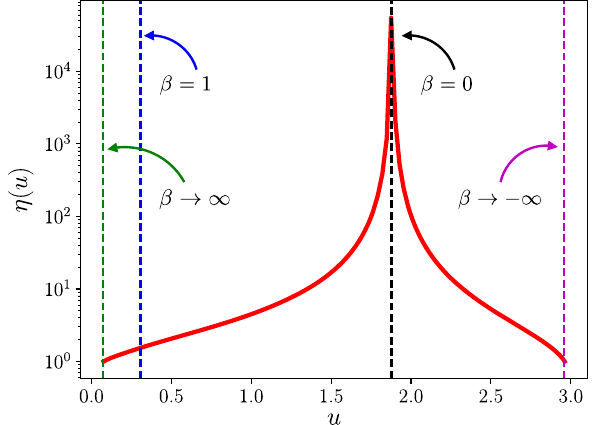
FIG. 9. Classical-to-quantum memory ratio for biased sampling of Ising spin configurations: η ð u Þ versus decay rate u for bias sampling of equal-energy density spin configurations. Vertical lines locate β ’ s corresponding to particular u s. Note that the memory ratio η ð u Þ diverges at u ¼ u 0 ≈ 1 . 878 , corresponding to β ¼ 0 . The quantum memory advantage is not limited to β ¼ 0 , but occurs in a large neighborhood around it. Quantitatively, for any arbitrary large number r , there exists a number ϵ for which the rare class β 0 ¼ ϵ has the memory ratio η ð β 0 Þ > r